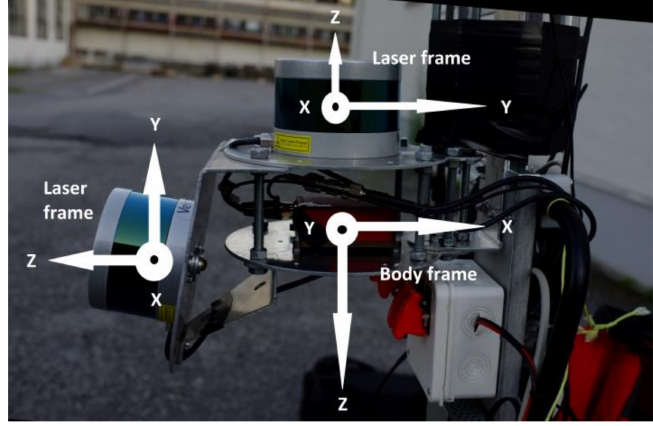
Figure 2. Location and orientation of the vertical and horizontal laser frames and body